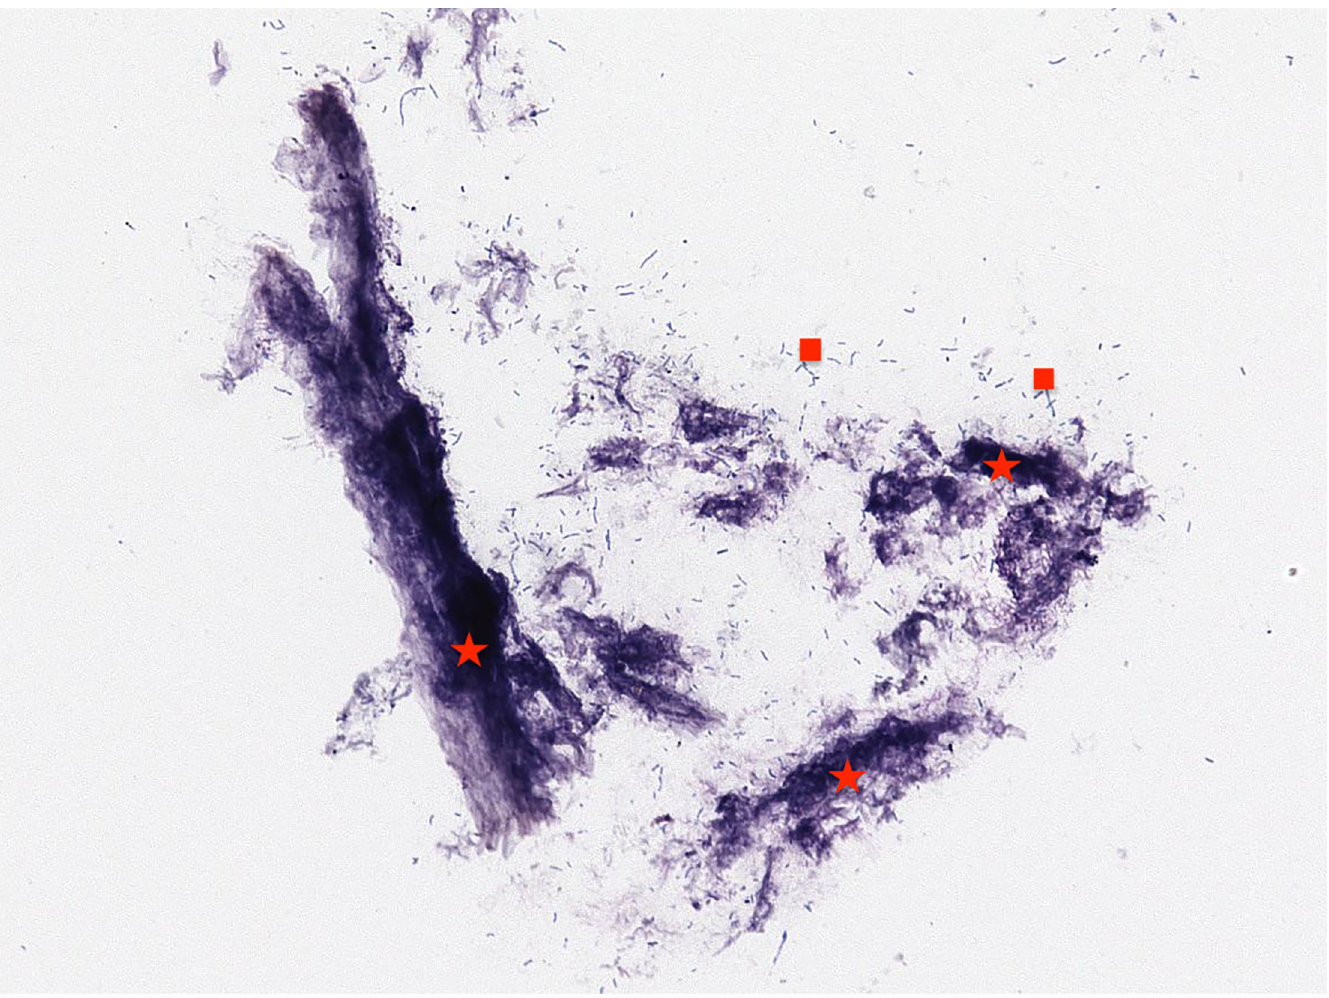
Fig 3. Cytological smears. Different bacterial elements, marked with red squares, along with sloughed keratinized epithelial scales, marked with red stars (May- Grunwald Geimsa staining, 40X).